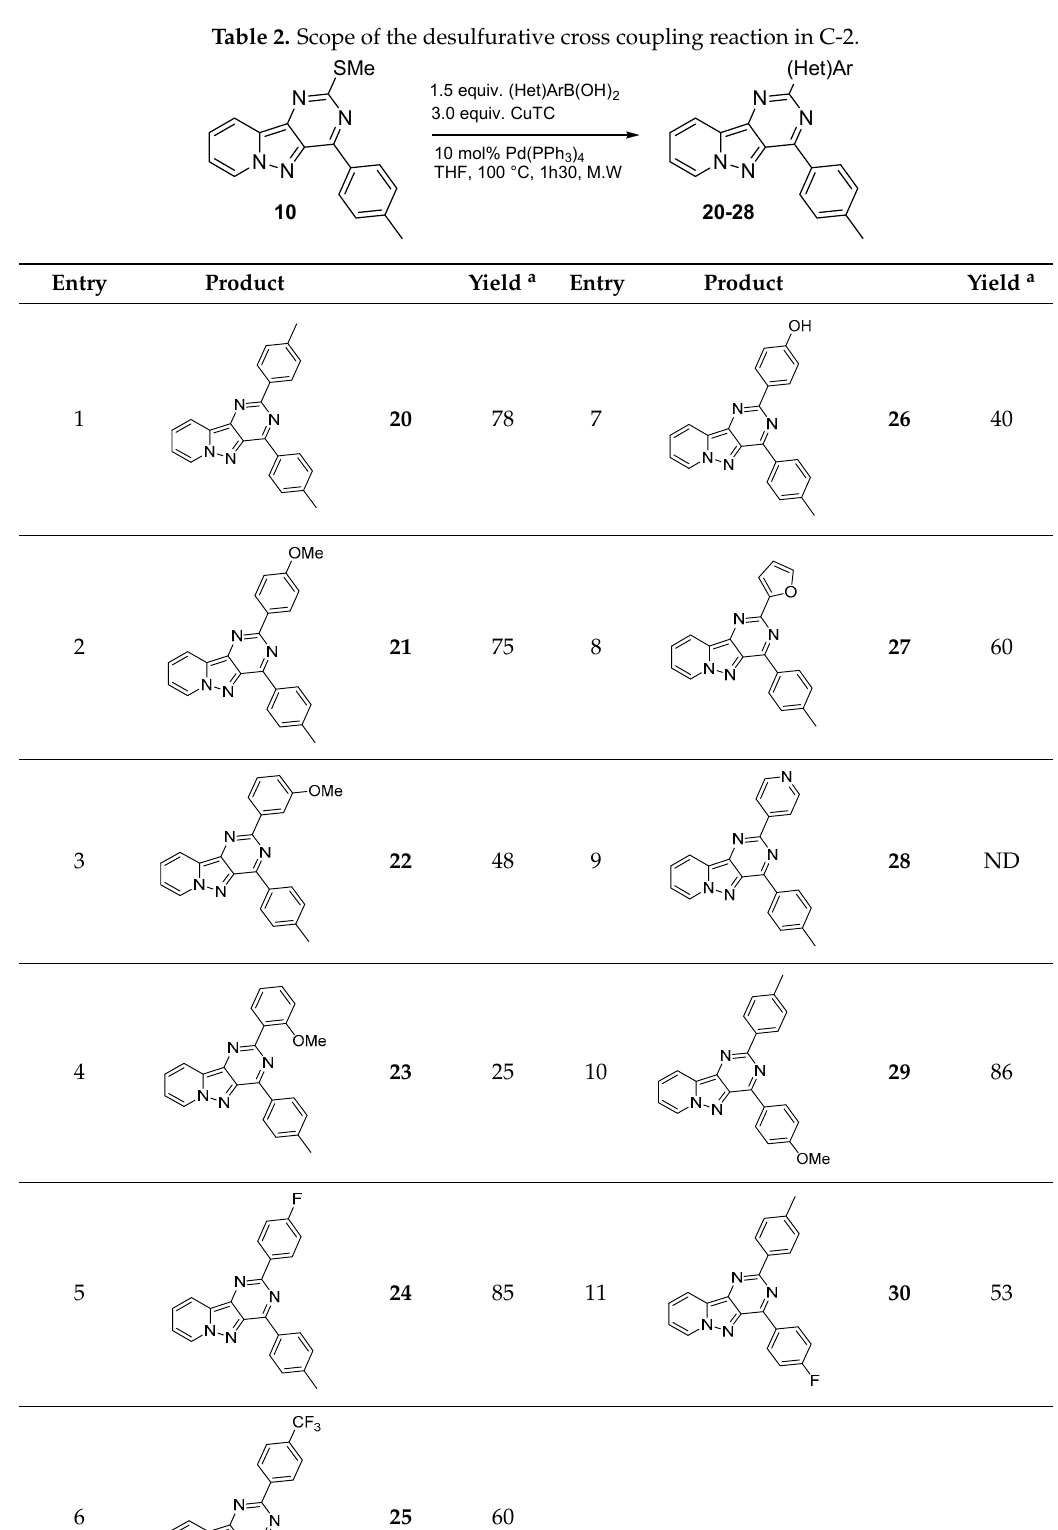
Table 2. Scope of the desulfurative cross coupling reaction in C-2.